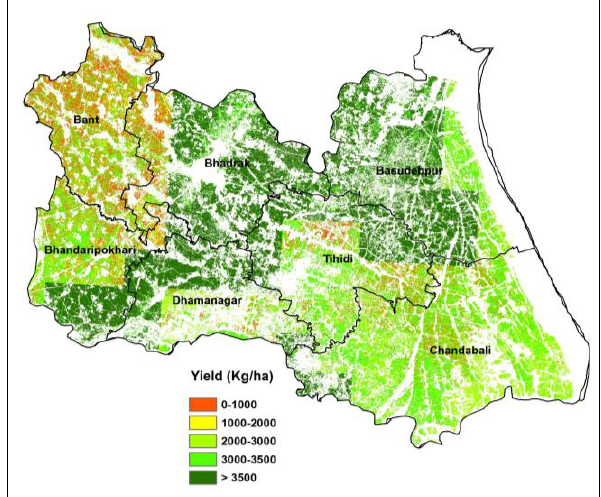
Figure.6. Simulated Yield map for Kharif rice in Bhadrak during